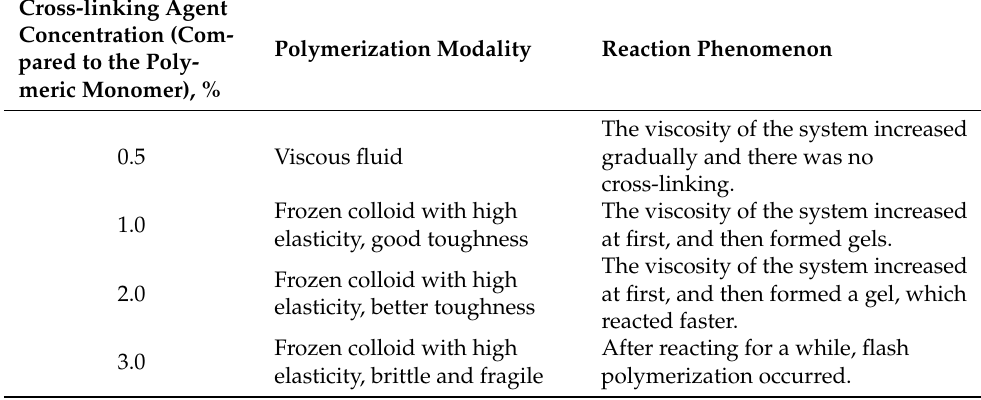
Table 3. Reaction forms of different concentrations of